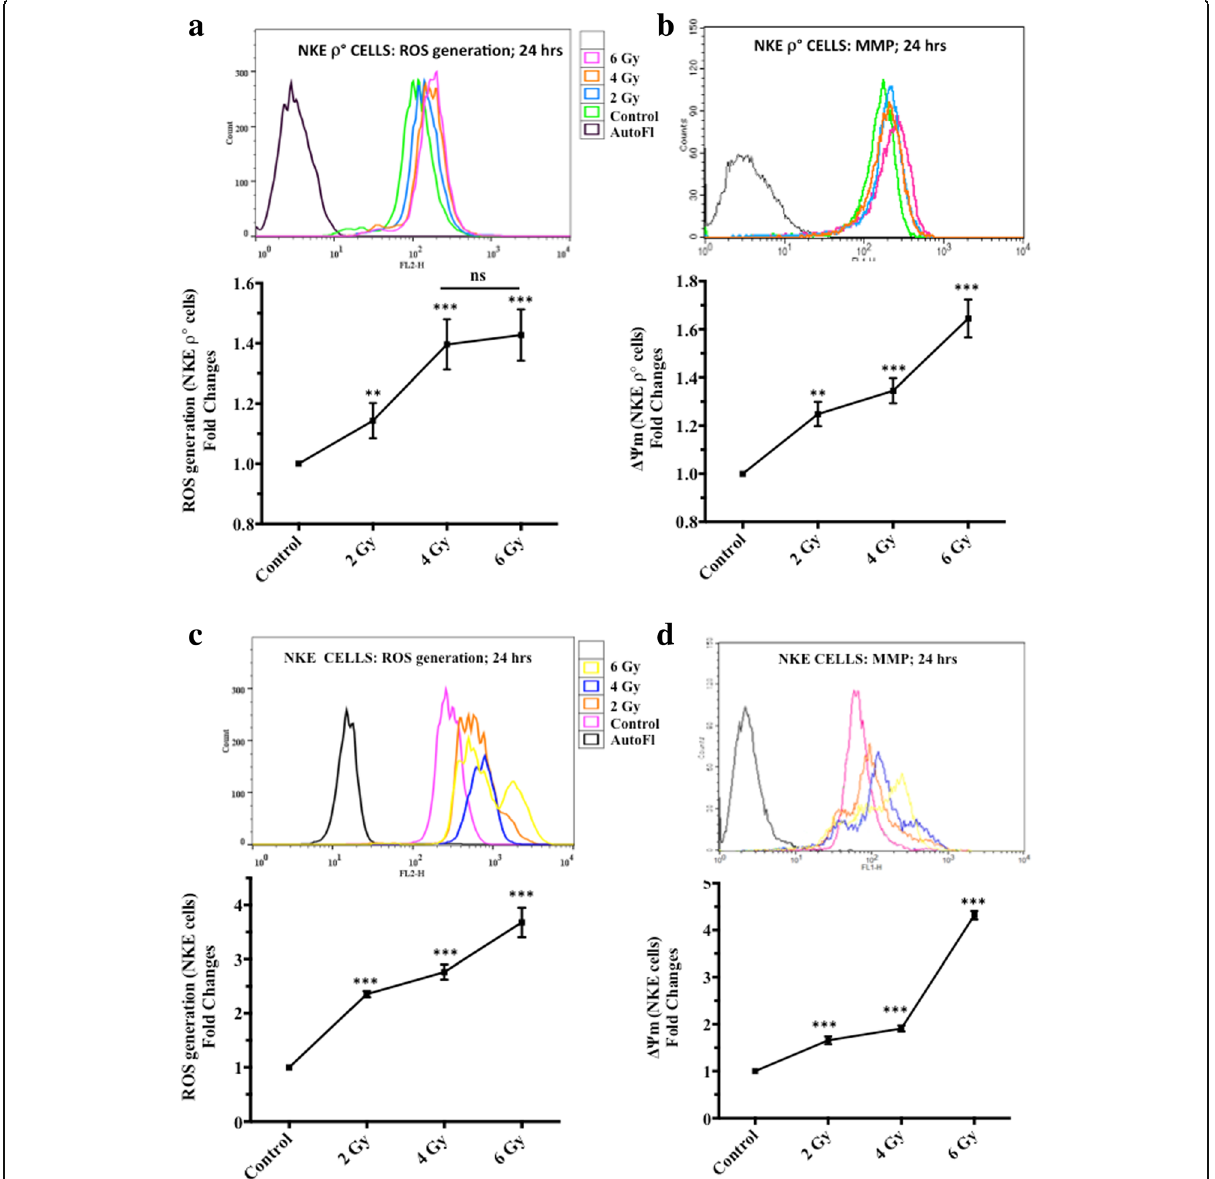
NKE cells ( c-d ). ROS levels and ΔΨ m were measured by flow cytometry using DHE and DiOC 6 (3), respectively as described in materials and method section. Histograms presented are representative of three independent experiments. Results are also expressed as fluorescence mean±SD of three independent experiments. Differences were designated significant at values, ** p <0.01, *** p <0.001 and were labeled as * compared with the 3 Gy (radiation only) group. Data was analyzed using FlowJo V10.1